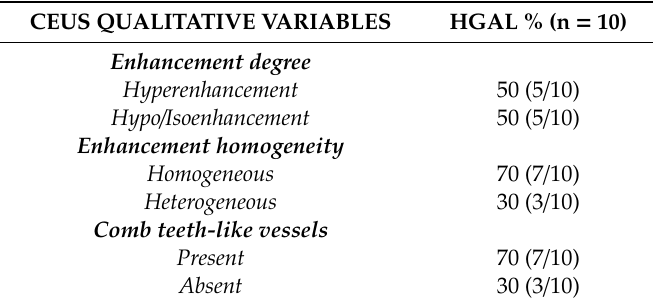
Table 4. Number of cases ( n ) and percentage (%) showing qualitative variables (enhancement pattern) on CEUS for high-grade alimentary lymphoma (HGAL).